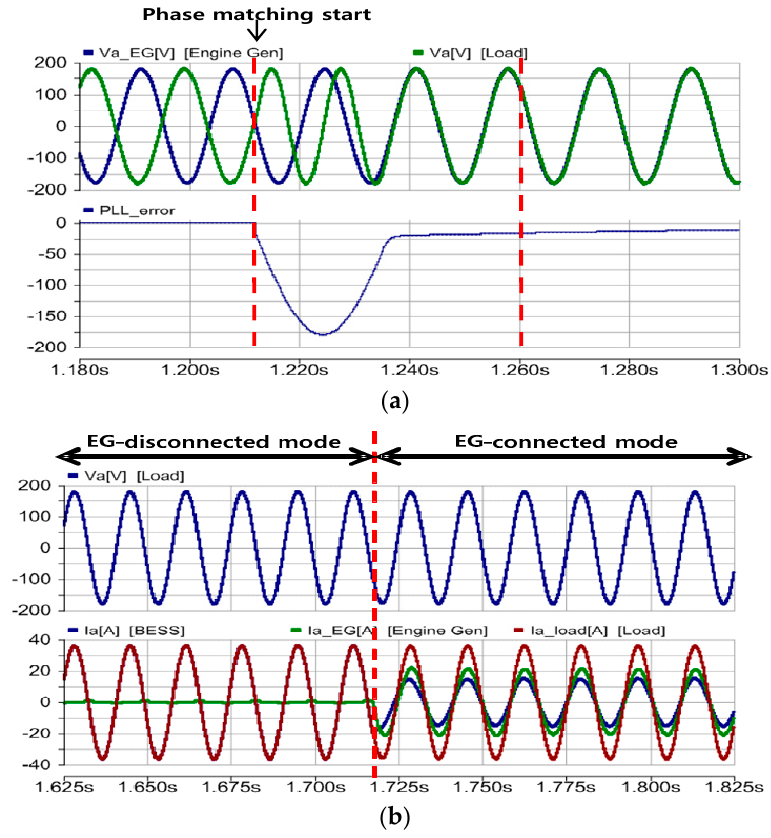
Figure 11. Mode change from voltage control to current control: ( a ) Phase angle tracking; ( b ) Voltage and current variations. Fix mistake in figure label: EG ‐ connected